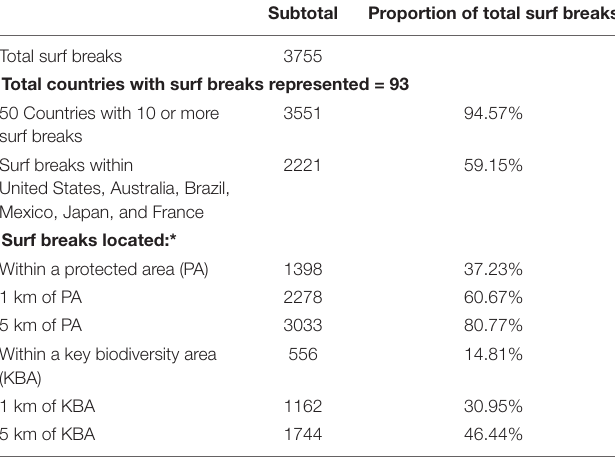
Table includes surf break co-location with protected areas and key biodiversity areas. *I.e., The surf break’s point location or else a 1 or 5 km buffer around its point location break overlaps a protected area or KBA.